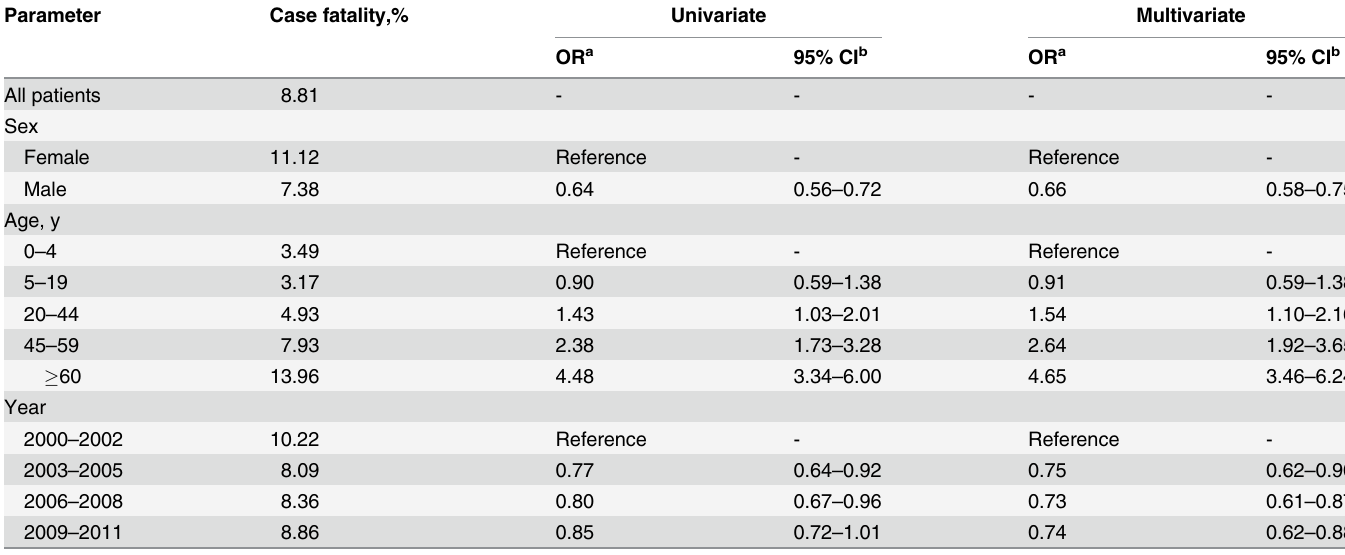
Table 3. Multivariable logistic regression analysis of in-hospital mortality for patients with